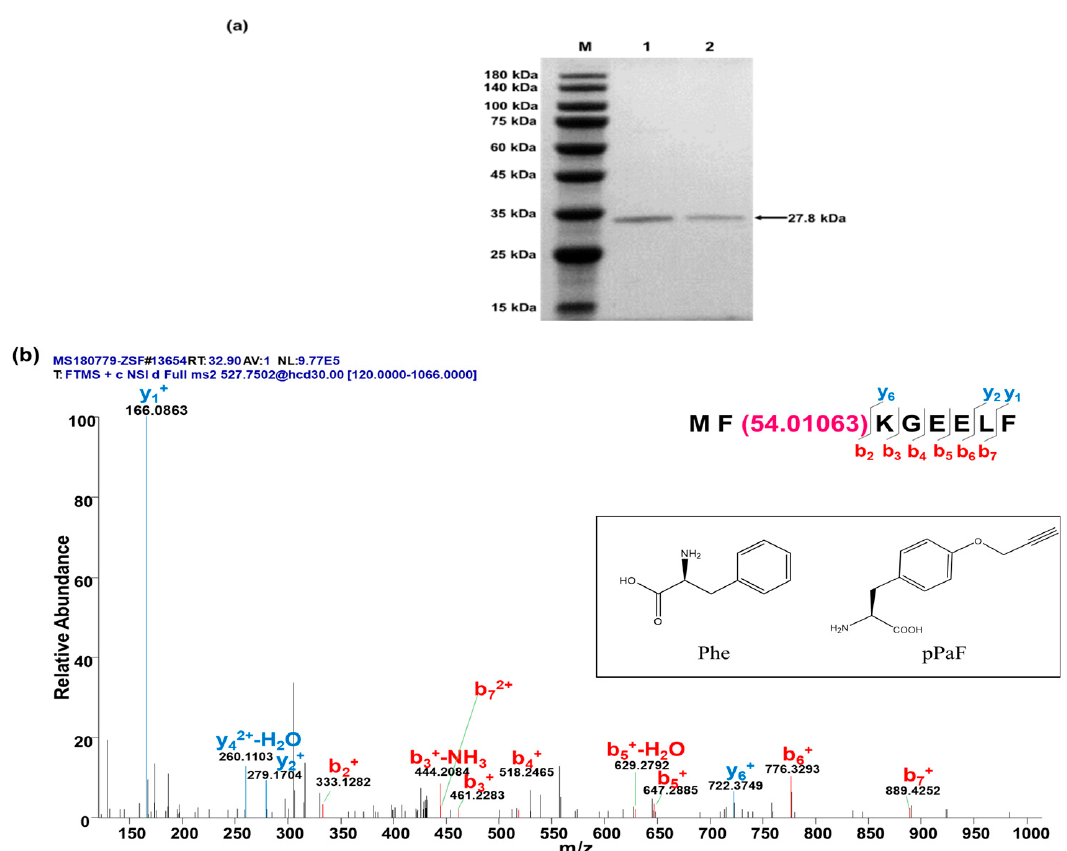
Figure 4. ( a ) Purified protein with C-terminal Strep-tag. 1: wild-type sfGFP; 2: sfGFP2 p PaF. ( b ) LC-MS/MS analysis of sfGFP2 p PaF.